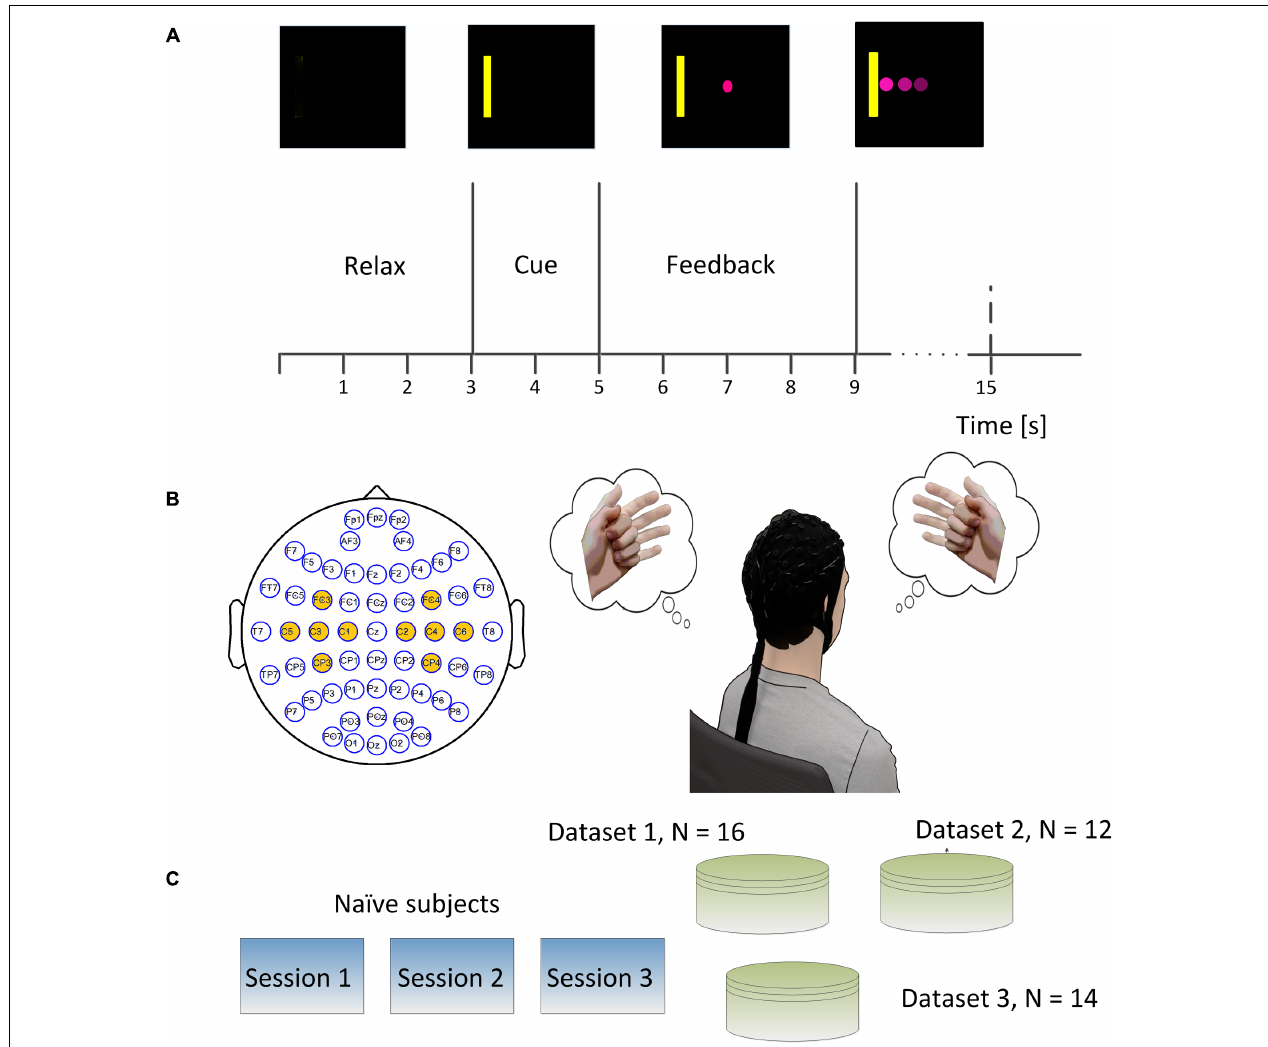
FIGURE 1 | (A) Brain-computer interface (BCI) single trial structure. Each trial started from a blank screen of 3 s during which subjects should relax and have a short break. Then a yellow rectangle appeared either on the left side or right side of the screen at the end of second 3 and lasted for 2 s. A round pink cursor appeared at the center of screen at the end of second 5 and provided the online real time feedback. The cursor was supposed to move toward the left side or right side of the screen if subjects performed left hand or right hand motor imagination. The subjects were allowed hitting the correct target or the incorrect target within a period of 6 s, and then the cursor froze for 1 s during the post-feedback period. (B) The electrodes which were marked in yellow denoted the ones used for online control. The subject was supposed to imagine the left hand movement when the yellow bar appeared on the left side of the screen and imagine the right hand movement when the yellow bar appeared on the right side of the screen. (C) Experimental scheme of the study. Each of 42 naïve subjects participated in three sessions of online BCI control.